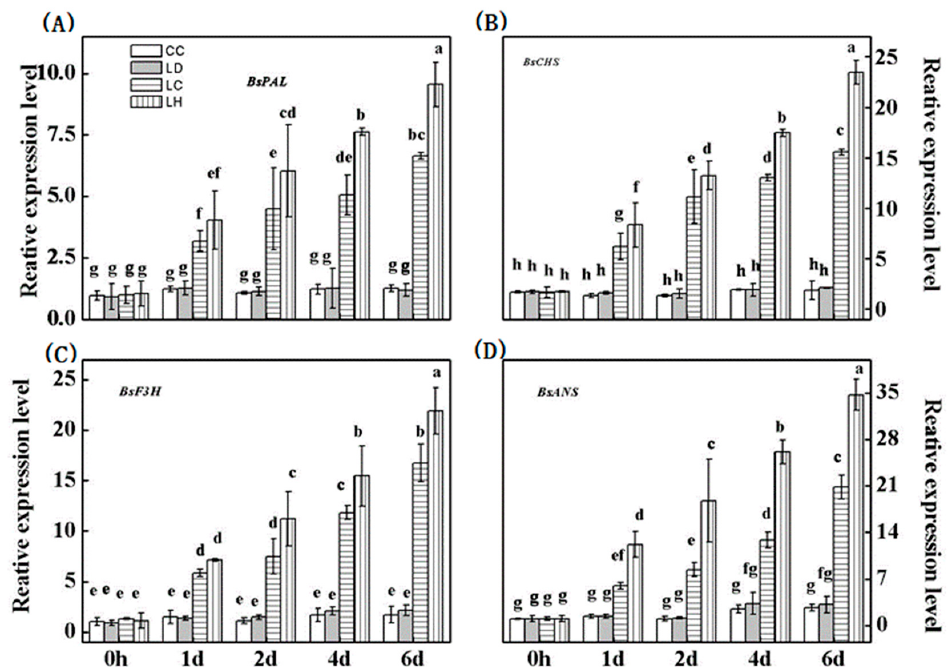
Figure 6. Changes in relative transcript levels of four key genes in anthocyanin biosynthesis ( BsPAL (Panel A ), BsCHS (Panel B ), BsF3H (Panel C ), and BsANS (Panel D )) in the leaves of B. semperflorens growing under CC (25 °C/15 °C, 300 µmol m –2 s –1 ), LD (15 °C/5 °C, 100 µmol m –2 s –1 ), LC (15 °C/5 °C, 300 µmol m –2 s –1 ), and LH (15 °C/5 °C, 500 µmol m –2 s –1 ) conditions. The values represent the means ± SDs ( stand deviatio ) of three replicates. Means denoted by the same letter (a, b, c, d, e, f, g, h) did not significantly differ at p < 0.05 according to Tukey’s test.